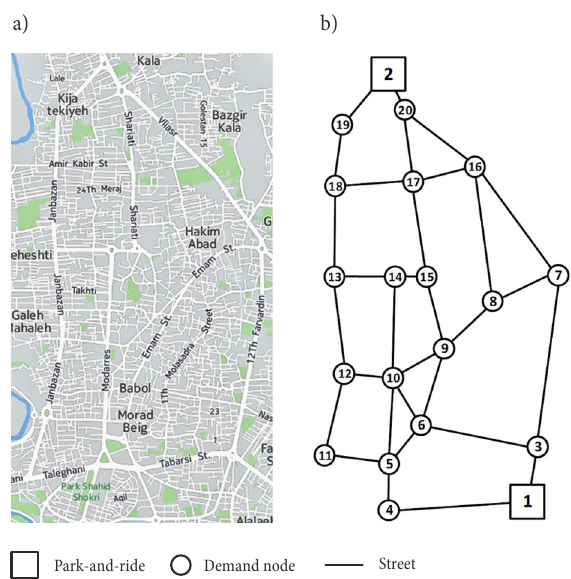
Fig. 5. Geographical map of Babol (a); transportation network of Babol (b) consisting of 2 park-and-rides and 18 demand nodes